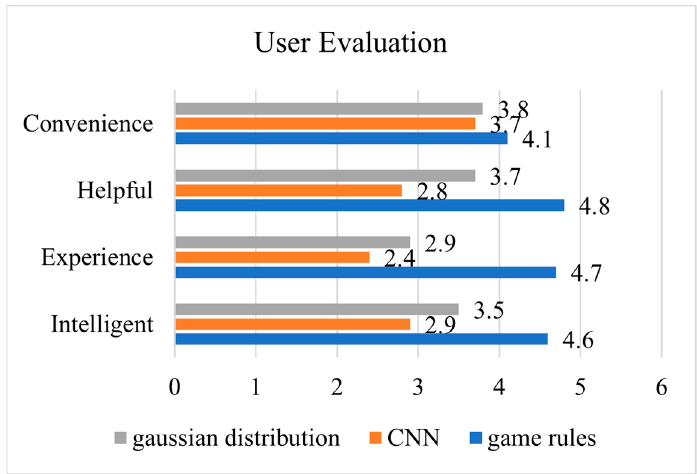
Figure 12. User experience evaluation.